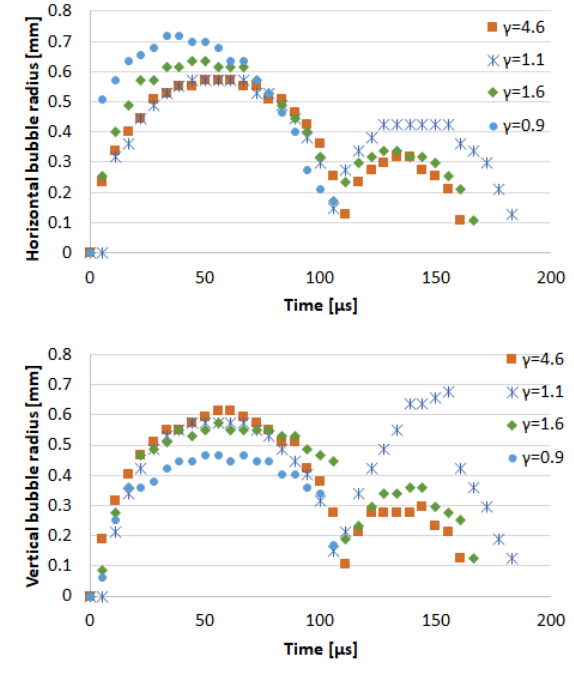
Fig. 7. Bubble radius in horizontal and vertical